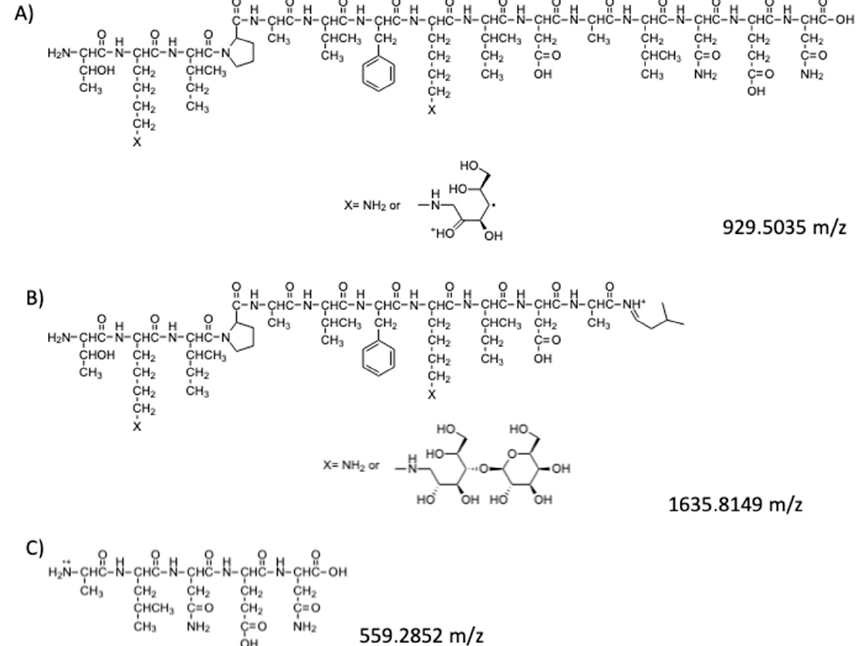
Figure 4. Peptides fragments identified in the HRMS / MS spectrum: ( A ) hypothesized structure for fragment at 929.5035 m / z ; ( B ) hypothesized structure for fragment at 1635.8149 m / z ; ( C ) hypothesized structure for fragment at 559.2852 m / z .